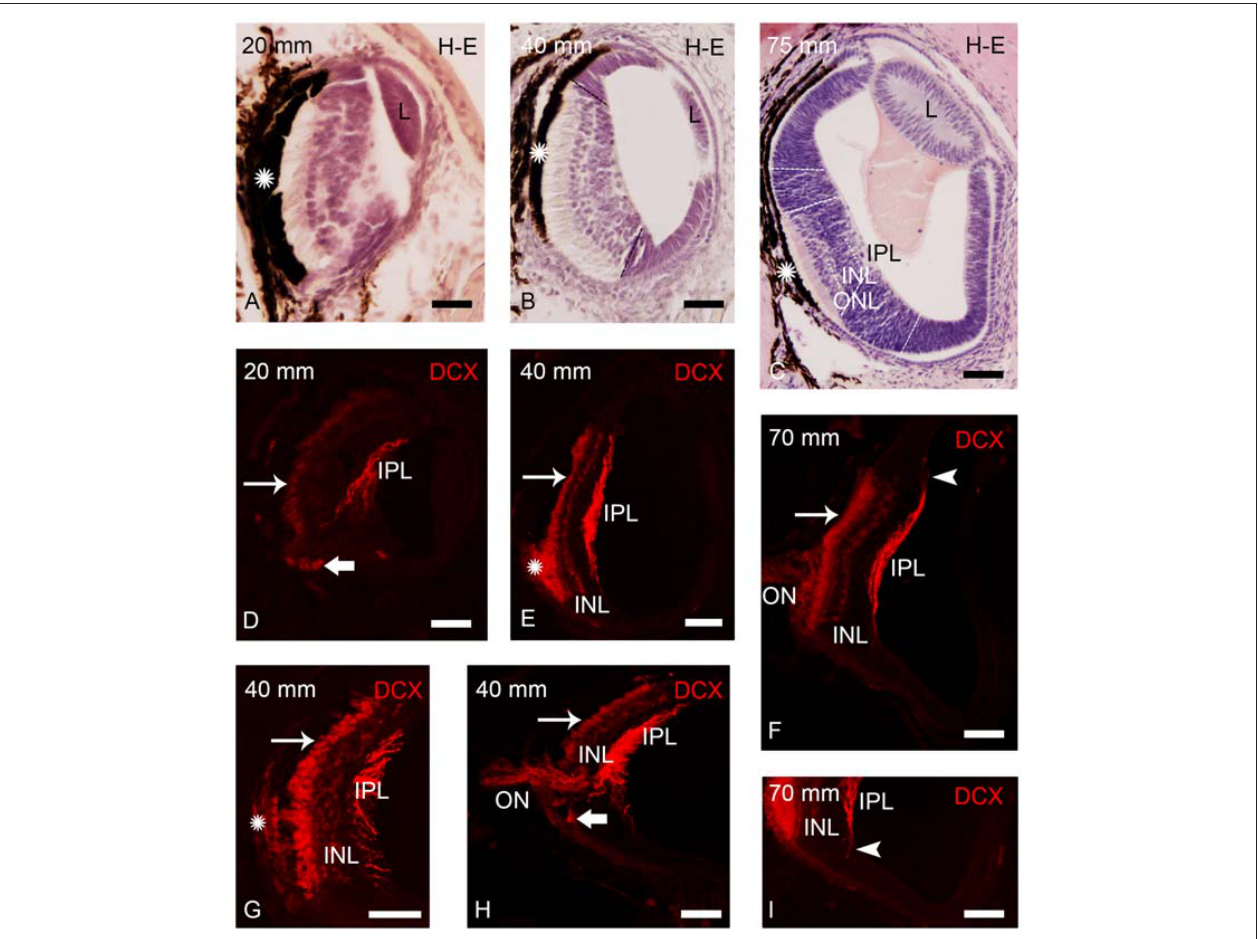
FIGURE 2 | Photomicrographs of transverse sections of retina of small larval lampreys stained with H-E (A–C) or immunostained for DCX (D–I). (A) Retina of an early larva (20 mm), in which only the central retina is present. Note also the presence of the retinal pigment epithelium (asterisk) and the crystalline lens (L). (B) Retina of a 40 mm larva, which shows the central and lateral retinas. (C) Central and lateral retinas in a larva of 75 mm. Dash lines mark the limit between the central and lateral retinas in (B,C) and also between the central and peripheral regions of the lateral retina in ( C ; see Villar-Cheda et al., 2008). Dotted lines mark the limits between layers in the central retina in (C) . (D) DCX immunoreactivity is observed in the perikarya of photoreceptors (thin arrow), in fibers of the inner plexiform layer (IPL) and in round cells located in the ventral retina, close to the exit of the optic fibers (thick arrow) in a 20 mm larva. (E) DCX immunoreactivity in a 40 mm larva. Expression is observed in the perikarya and the outer segments of photoreceptors, in fibers of the IPL and in cells of the outer layer of the inner nuclear layer (INL). The DCX-ir retinal pigment epithelium is indicated with an asterisk. (F) Retina of a 70 mm larva showing DCX immunoreactivity in the perikarya and outer segments of photoreceptors, in fibers of the optic nerve (ON) and in cells and fibers of the INL and IPL, respectively. (G) Detail of the central retina of a 40 mm larva. (H) Retina of a 40 mm larva showing DCX immunoreactivity in round cells of the ventral retina located close to the ON. (I) Detail of the retina of a 70 mm larva showing DCX-ir radial processes (arrowhead) in the boundary between the central and lateral retina. Note the absence of DCX immunoreactivity in the lateral retina. In all photomicrographs dorsal is up and medial is to the left. Scale bars: 25 µ m in (A,D,G,I) ; 50 µ m in (B,C,E,F,H)